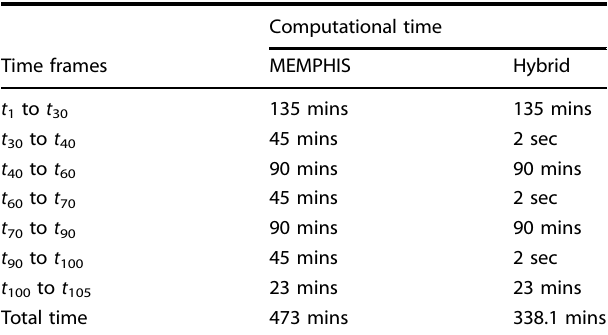
Table 3. A comparison between computational time for high- fi delity phase- fi eld simulations (MEMPHIS) and proposed hybrid model (Hybrid) for a single microstructure evolution realization from time frame t 1 to time frame t 105 .